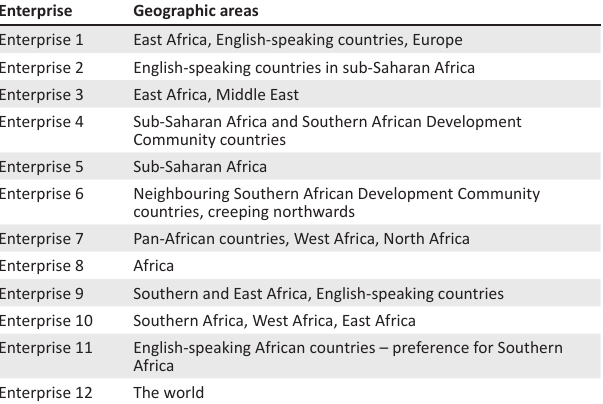
TABLE 2: Geographic areas considered by enterprises for possible expansion.